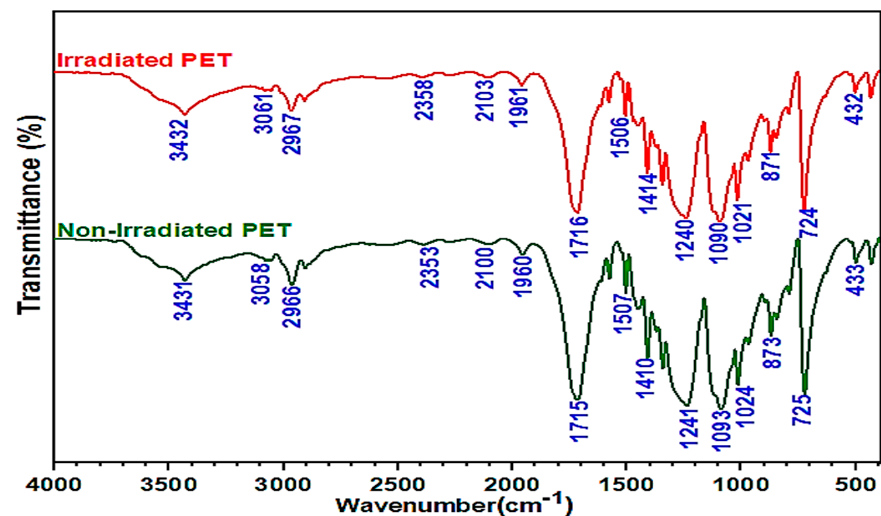
Figure 4. Fourier transformed infrared spectroscope (FT − IR) spectrum of regular and irradiated WPET.